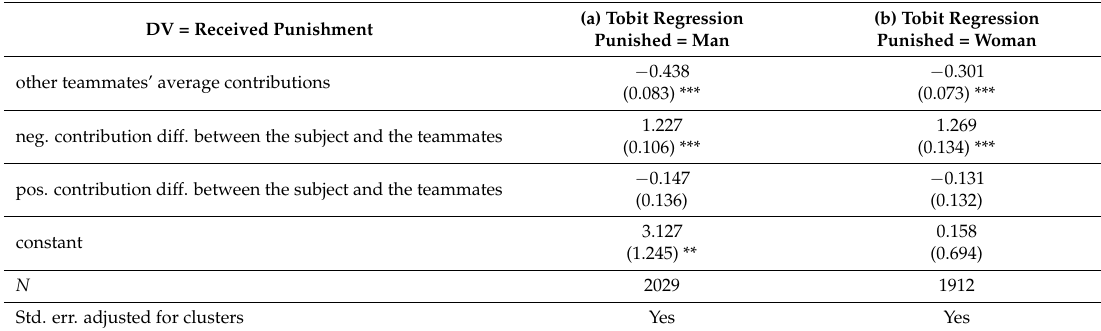
Table A2. Regression results on received punishment by (a) men and (b) women.